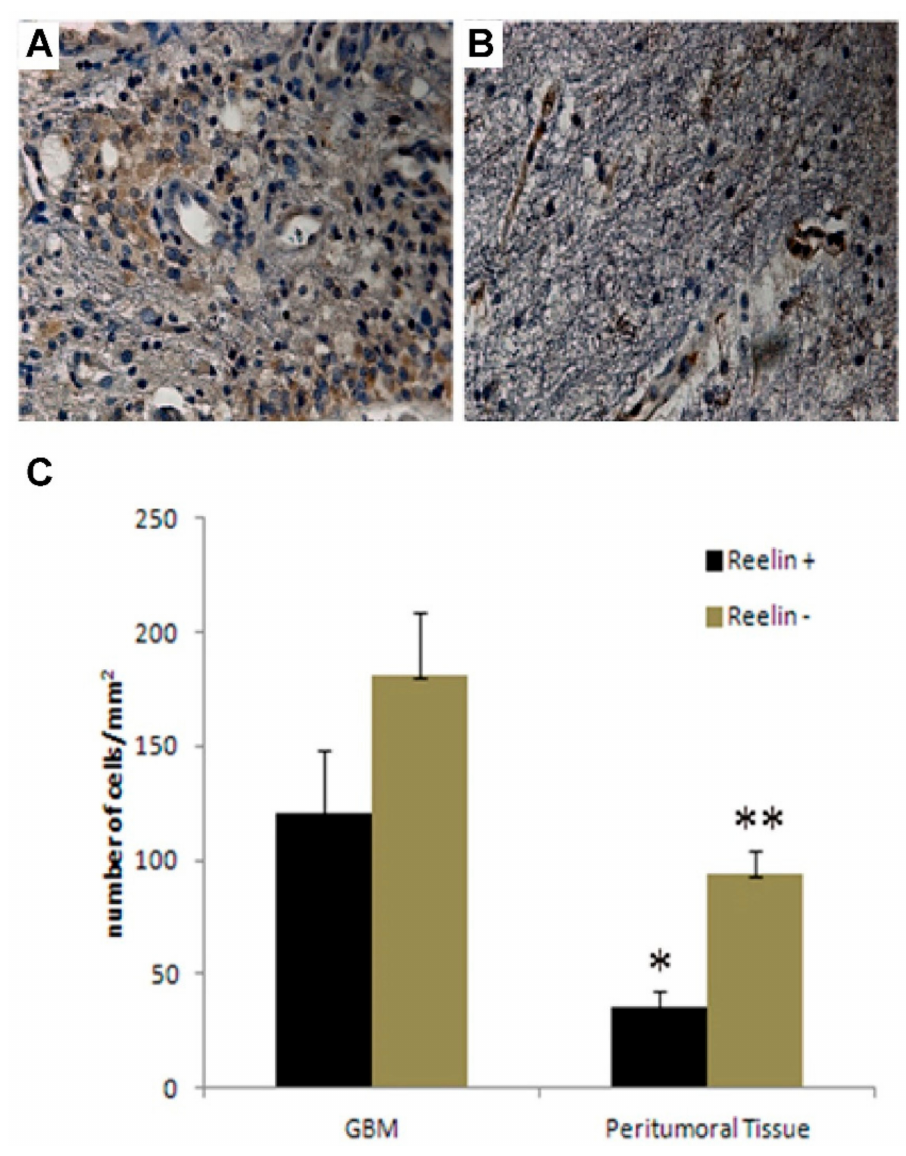
Figure 1. Expression of reelin and stereological analysis of GBM and peritumor tissue. ( A , B ), Im- munohistochemical analysis of reelin expression in GBM ( A ) and peritumor tissue ( B ), representative of 4 patients. In GBM, reelin immunopositivity was detected in the cytoplasm of tumor cells and in endothelial cells. ( B ), reelin immunolocalization in the endothelium, and in the cytoplasm of apparently normal cells of peritumor tissue. ( C ) Stereological analysis of cell density in both GBM and peritumor tissue from 4 different patients. Cell density was determined by dividing cell counts by the area of the ROI, (* p = 0.02; ** p = 0.015). Bars show the mean of cell counts ± standard deviation of 4 GBM